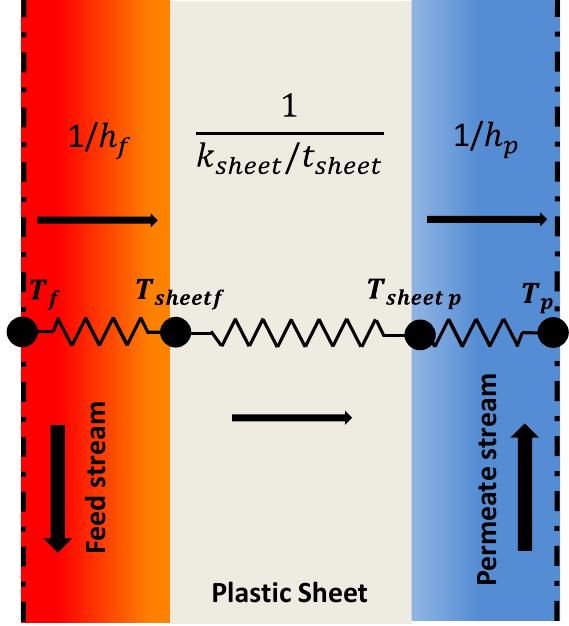
Figure 3. The thermal resistance series in empty and spacer-filled channels.